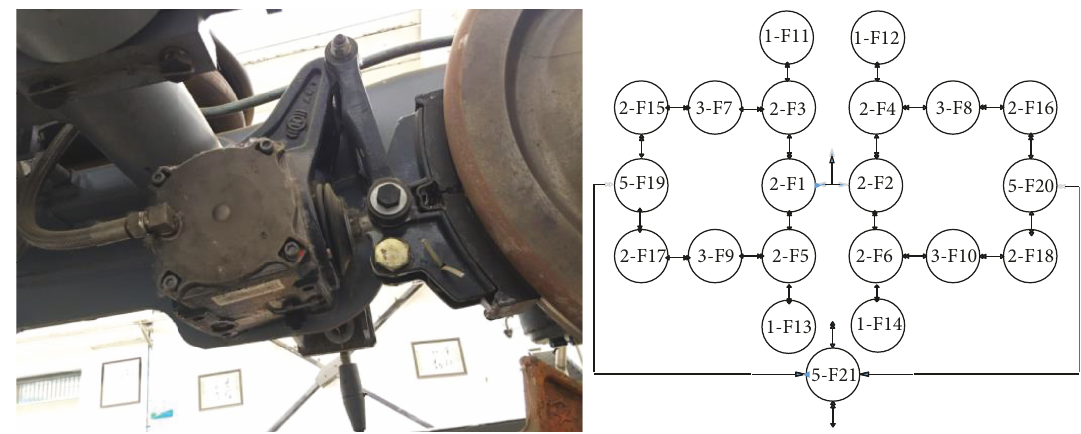
Figure 10: Model of a basic braking device.